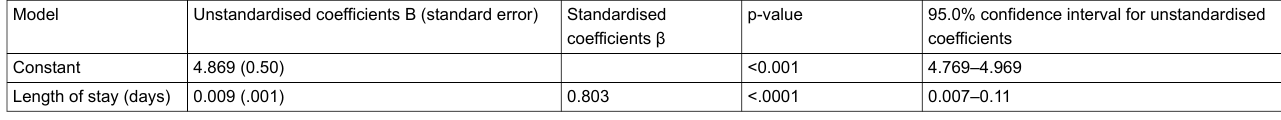
Table S3: Summary of regression coefficients – linear regression model predicting the decadic logarithm of total costs per case. Study population: discharges from the University Hospital of Zurich (n = 56).